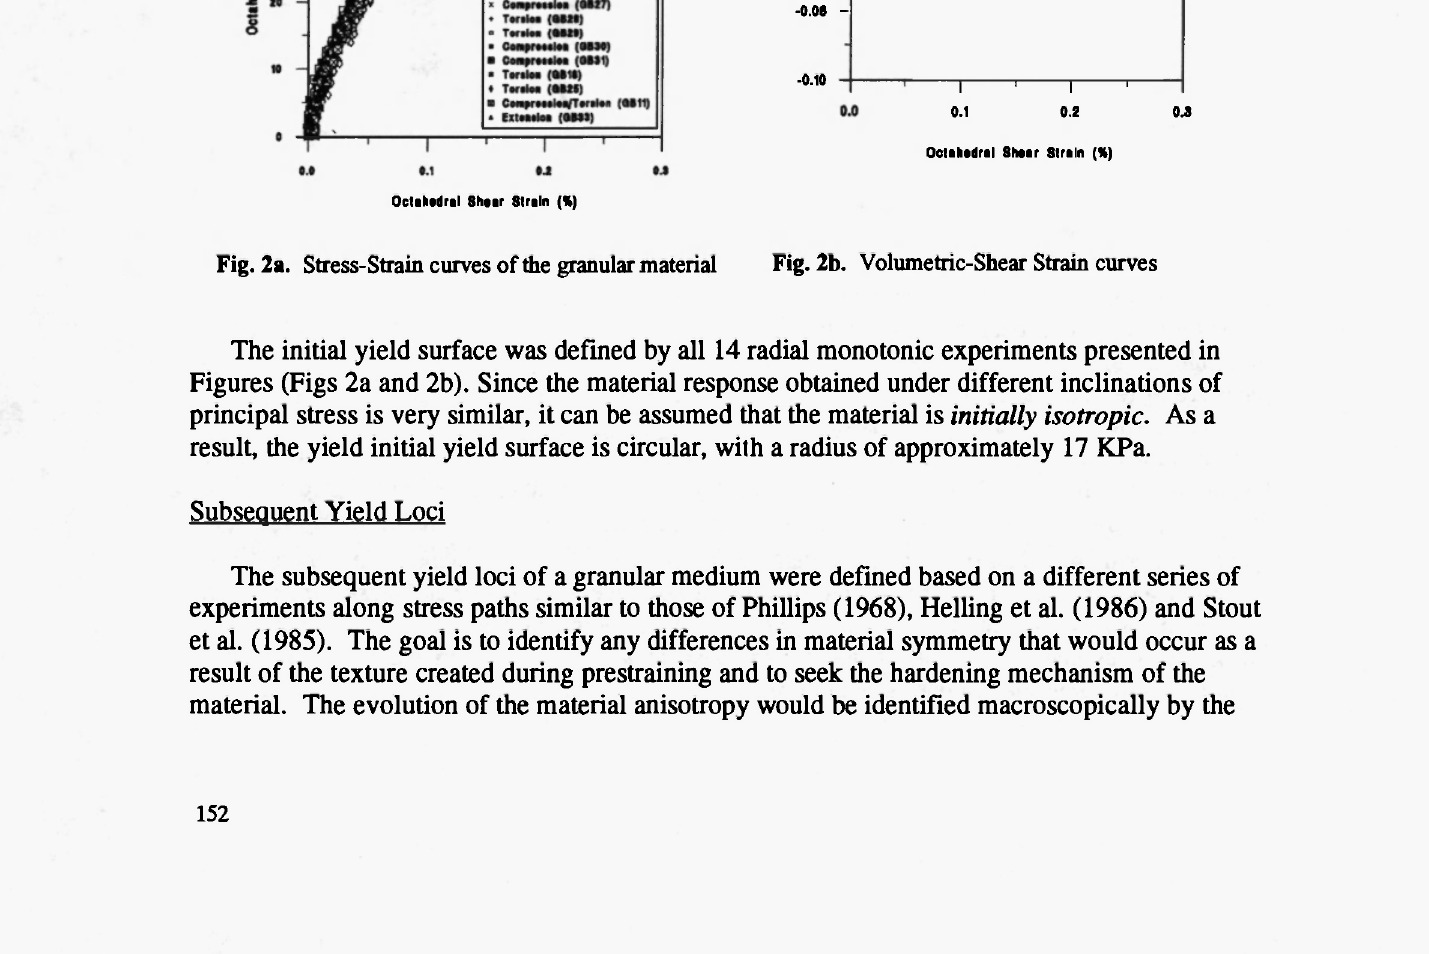
Fig. 2a. Stress-Strain curves of the granular material Fig. 2b. Volumetric-Shear Strain